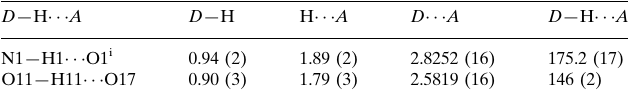
The geometric parameters of compound,